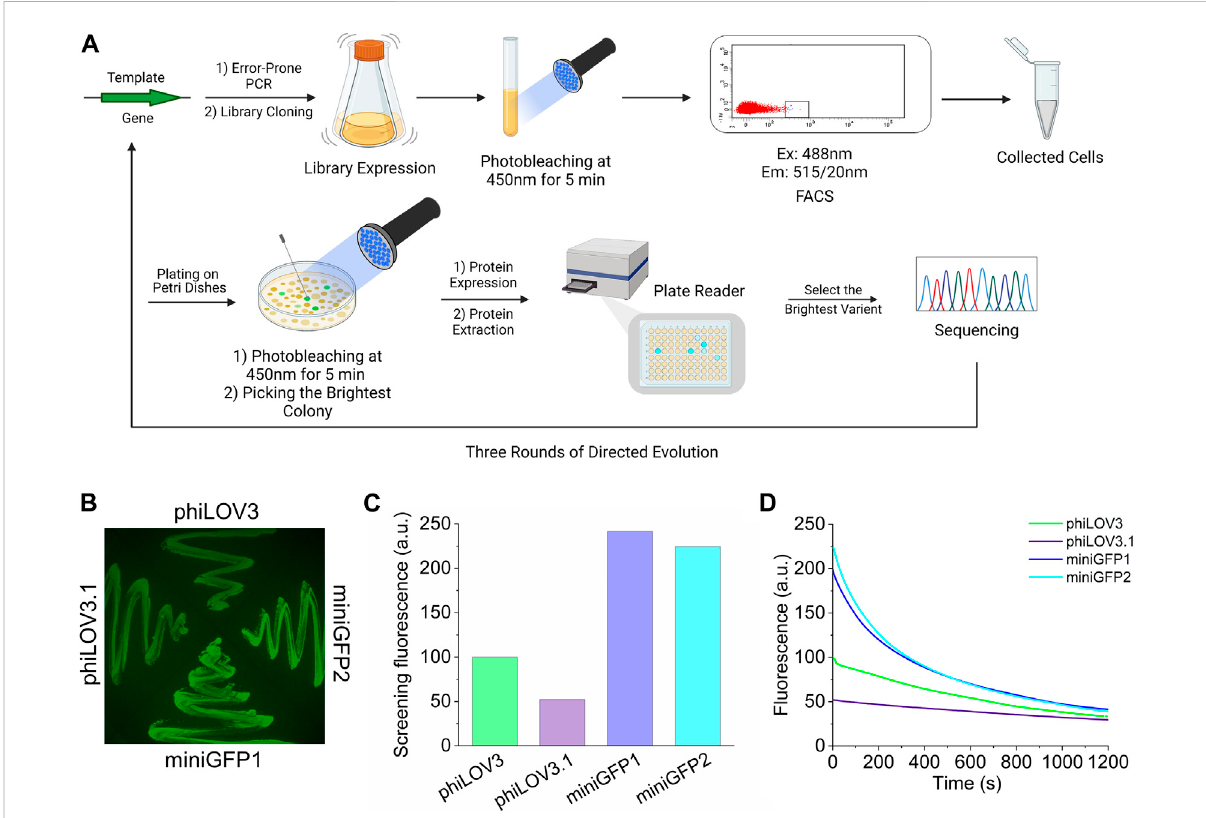
FIGURE 1 Development of small GFPs. (A) Work fl ow of directed molecular evolution of the fl avin-binding miniGFPs in E.coli . FACS, fl uorescent-activated cell sorting. (B) Fluorescence image in the green channel of E. coli streaks on LB/agar plate expressing phiLOV3, phiLOV3.1 (an intermediate mutant from the second round of evolution), miniGFP1, and miniGFP2. (C) Screening green fl uorescence intensity of bacterial streaks shown in (B) . (D) Screening photobleaching curves for phiLOV3, phiLOV3.1, miniGFP1, and miniGFP2 in E. coli under continuous wide- fi eld